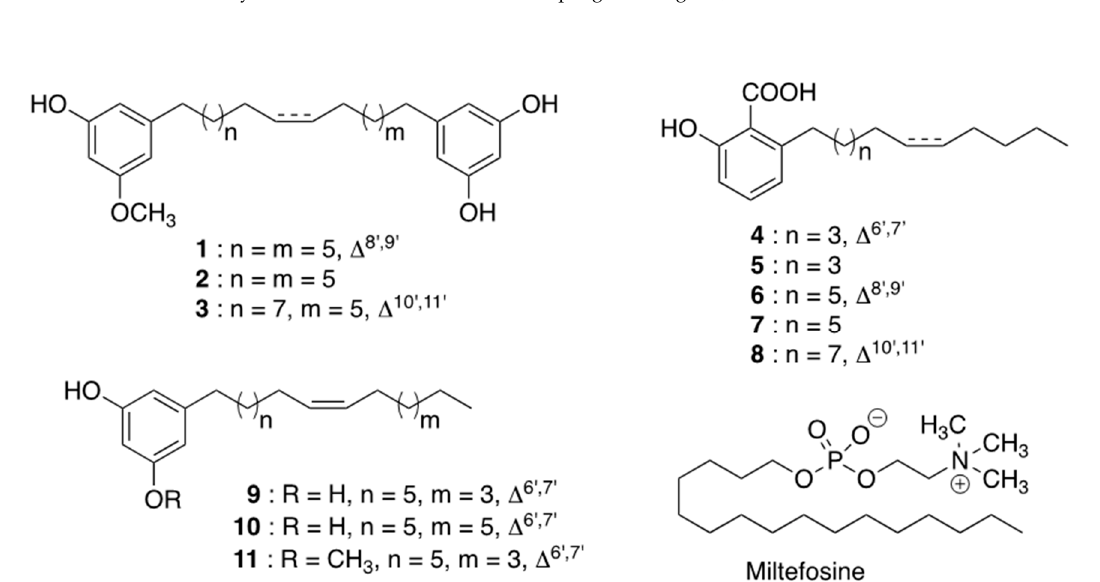
Table 1. Evaluation of resorcinol derivatives on Li GDP-MP, h GDP-MP, and on L. infantum axenic and intramacrophage amastigotes, and their cytotoxicity.